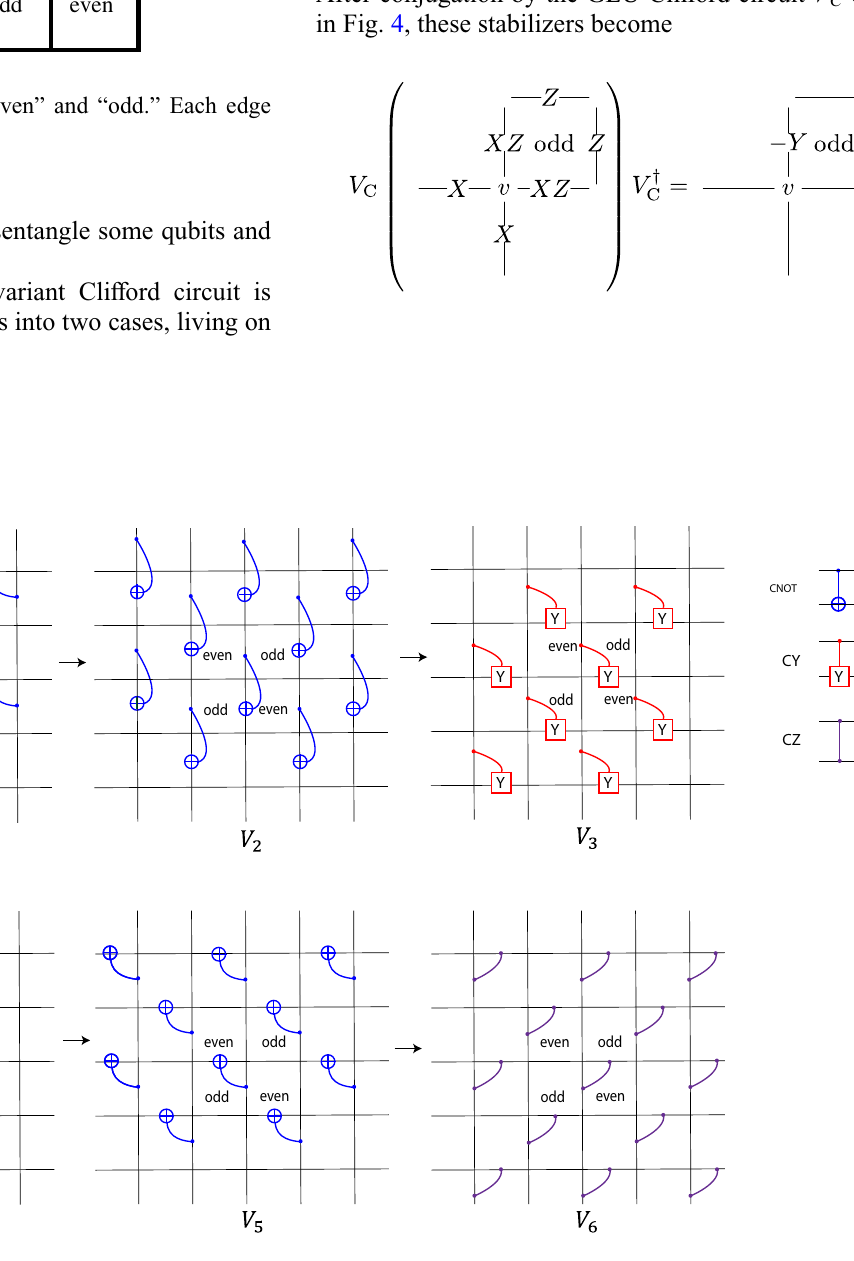
FIG. 4. The finite-depth Clifford circuit for the r = 1.5 construction. Here CY denotes the controlled- Y gate. The depicted unitaries are denoted in the sequence as V 1 , V 2 , V 3 , V 4 , V 5 , V 6 . The total GLU disentangler is V C ≡ V 6 V 5 V 4 V 3 V 2 V 1 . After conjugation by unitary operator V C , a part of the stabilizers in Eq. (17) becomes a single Pauli matrix, which can be removed from the